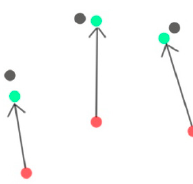
Figure 7. Position correction: the black point in Figure 7 is the high-precision point cloud, the red point is the point cloud to be registered and the green is the point cloud after